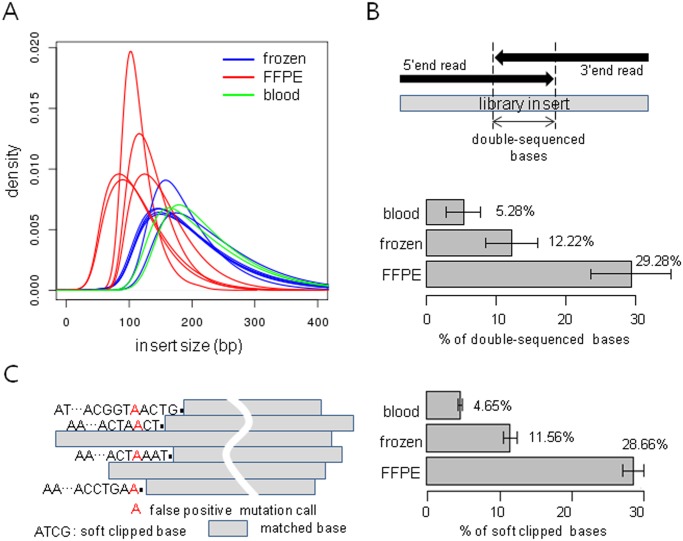
Distribution of insert sizes and frequencies of double-sequenced regions.The distribution of insert sizes was calculated from properly mapped paired reads. The distributions of formalin-fixed paraffin-embedded (FFPE) samples were skewed to the left because of a large number of short inserts (A). The short inserts generated abundant overlapping paired ends in FFPE samples (B), and soft clipped bases (C).